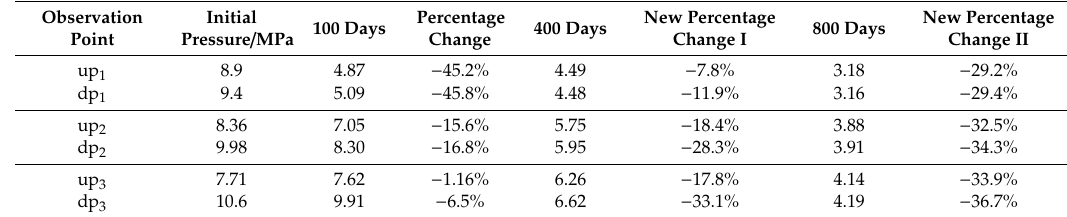
Table 2. Pressure distributions of the reservoir at di ff erent observation points during